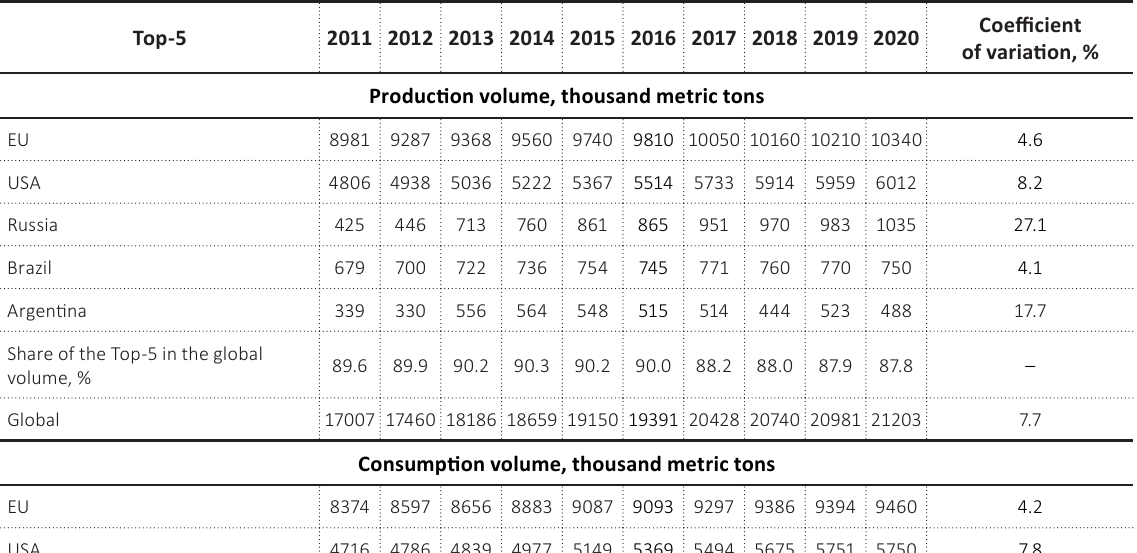
Source: U. S. Department of Agriculture